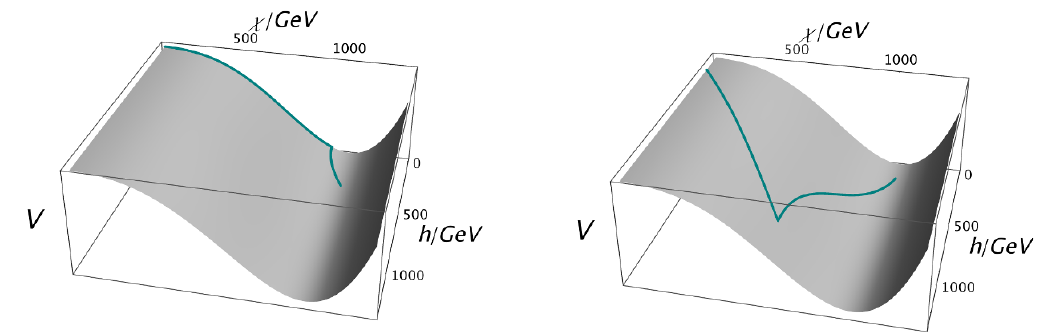
Figure 3 . Examples of potentials with a valley along the direction h = 0 (left plot) and with a valley along h (cid:24) (cid:31) (right plot). The green line shows the (cid:31) -dependent minimum of the Higgs potential. Since the Higgs potential is loop-suppressed with respect to the dilaton potential, and we assume order-one values of the mixings y , the valleys are not very pronounced.